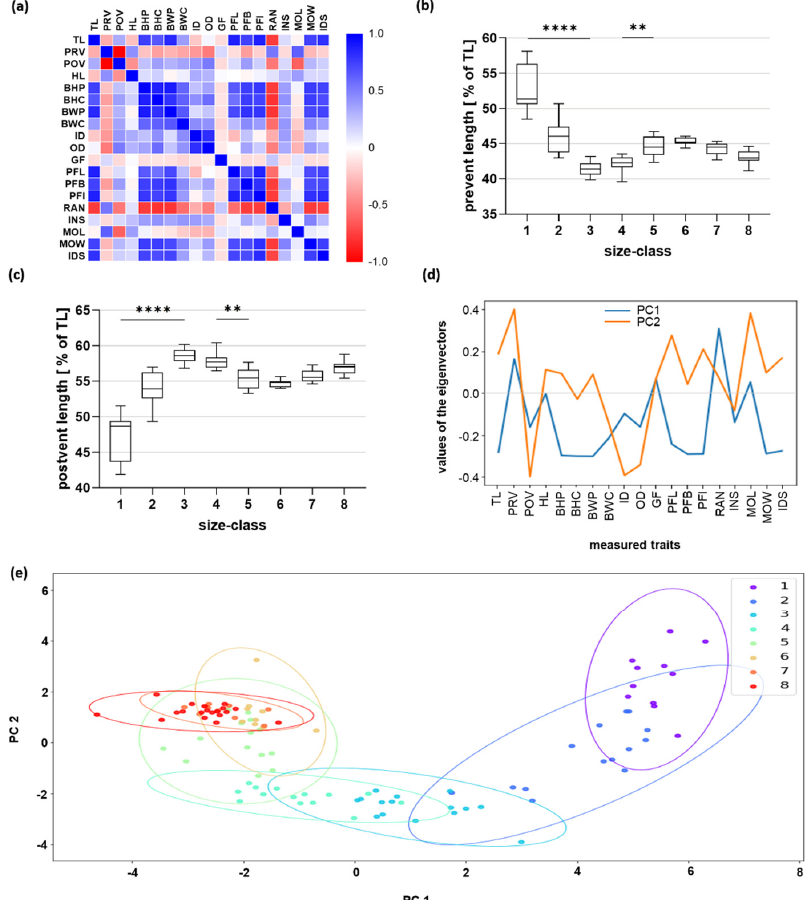
Figure 4. Analysis of morphometric features in relation to total length. ( a ) Correlation matrix of the obtained body parameters. The values for the Pearson correlation coefficient are color coded. ( b , c ) Changes in pre-vent length ( b ) and post-vent length ( c ) calculated in relation to TL of Scyliorhinus canicula with increasing size classes. Significant changes are indicated by ** p < 0.01, **** p < 0.001. ( d , e ) Results of the principal component analysis. ( d ) Values of the eigenvectors for the first two principal components (PCs). Contribution of the parameters to each PC is shown by the value of the eigenvector. ( e ) Plot of the first two PCs. Results are shown for each size class (color coded). A shift in the ratios of PRV and POV despite bilateral growth in each age group is present (Figure 4b,c). In PRV, after a significant decrease between the first three size